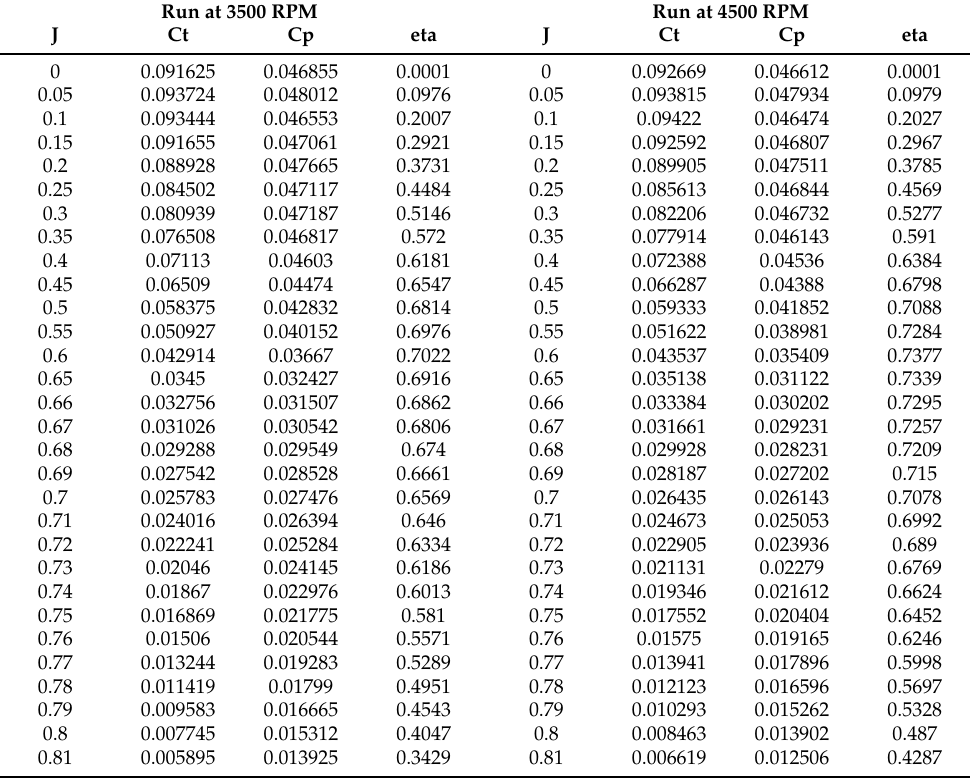
Table A20. BEMT 16 × 12 APC propeller